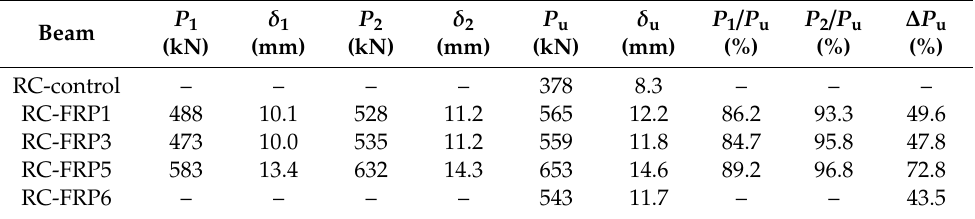
Table 7. Characteristics load of the RC beams.